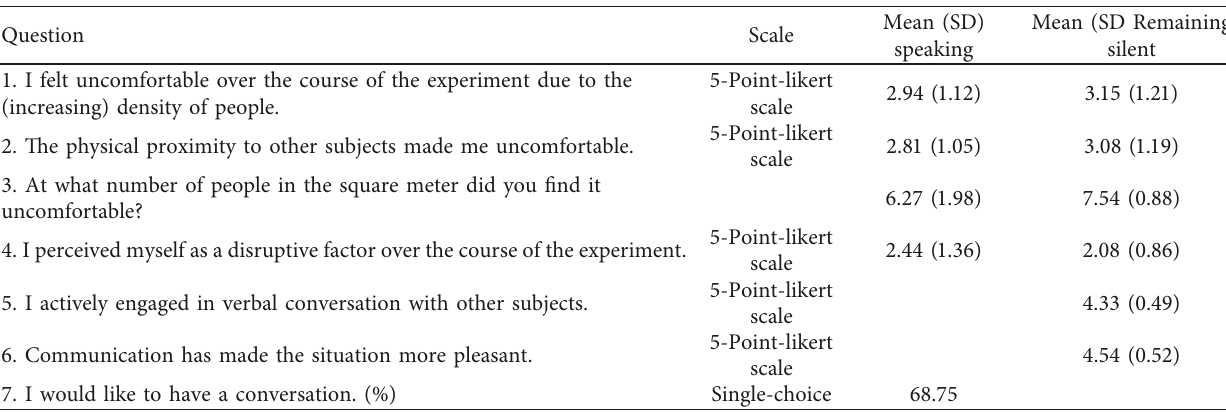
Table 2: Questionnaire